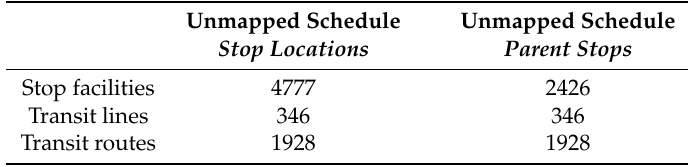
Table 1. Statistics on the unmapped schedules used for analysis.